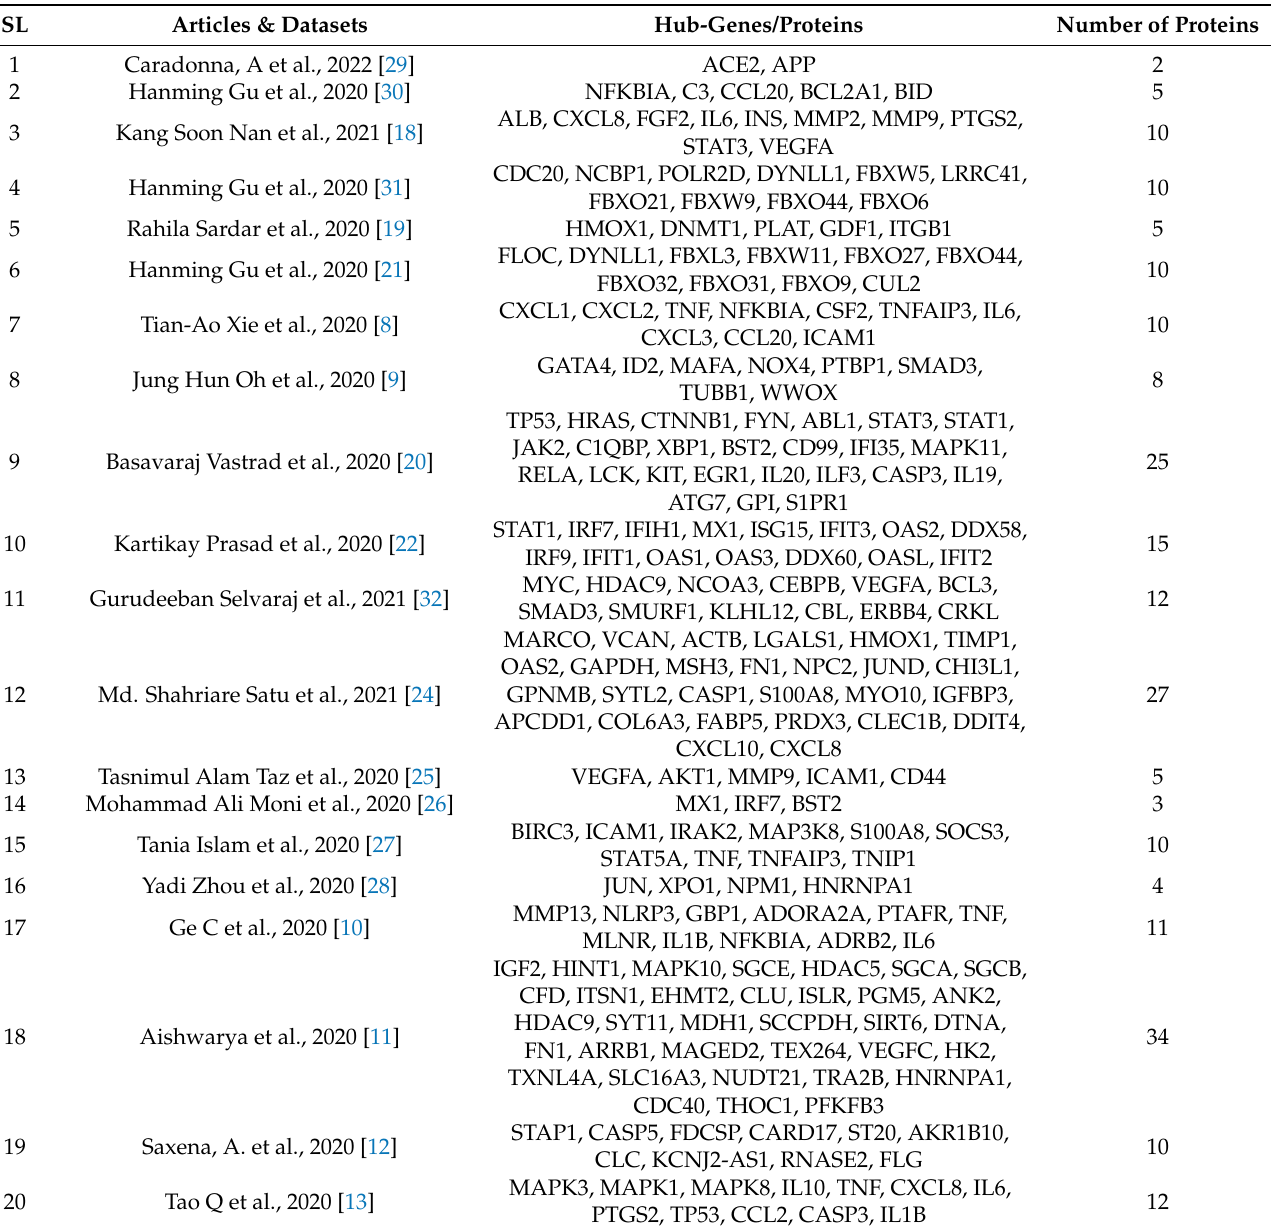
Table 1. Hub genes/proteins that were associated with SARS-CoV-2 infections in different